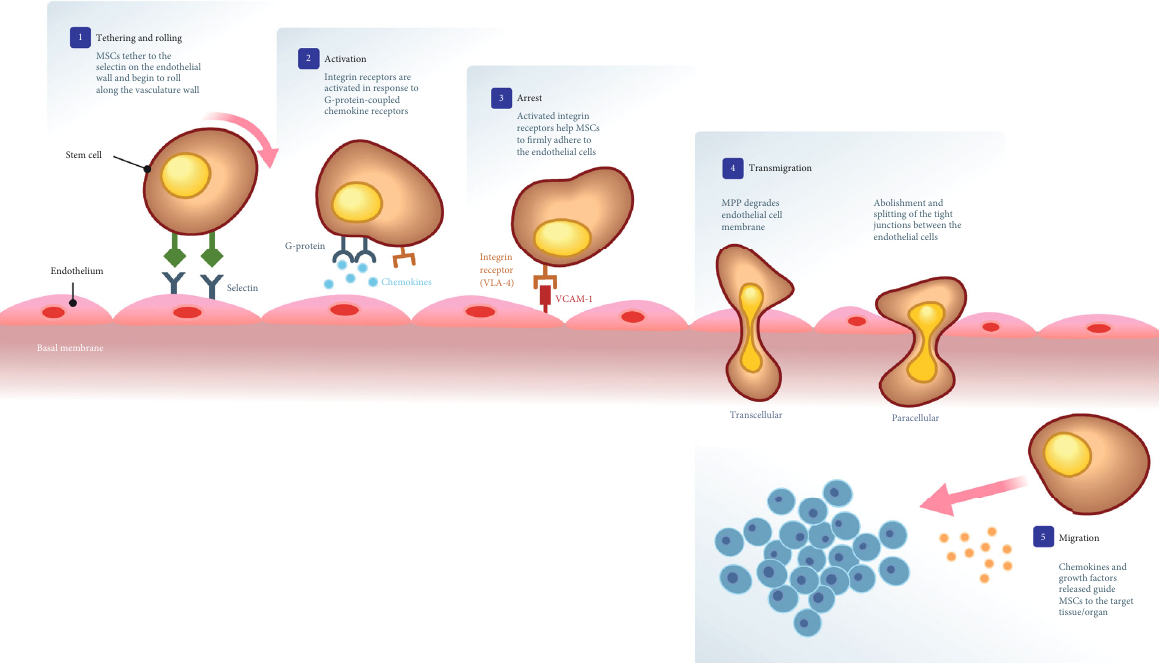
Figure 1: The multistep cascade of MSC homing mechanism consists of fi ve di ff erent steps, namely, (1) tethering and rolling, (2) activation by cytokines, (3) cell arrest by integrins, (4) transmigration, and (5)